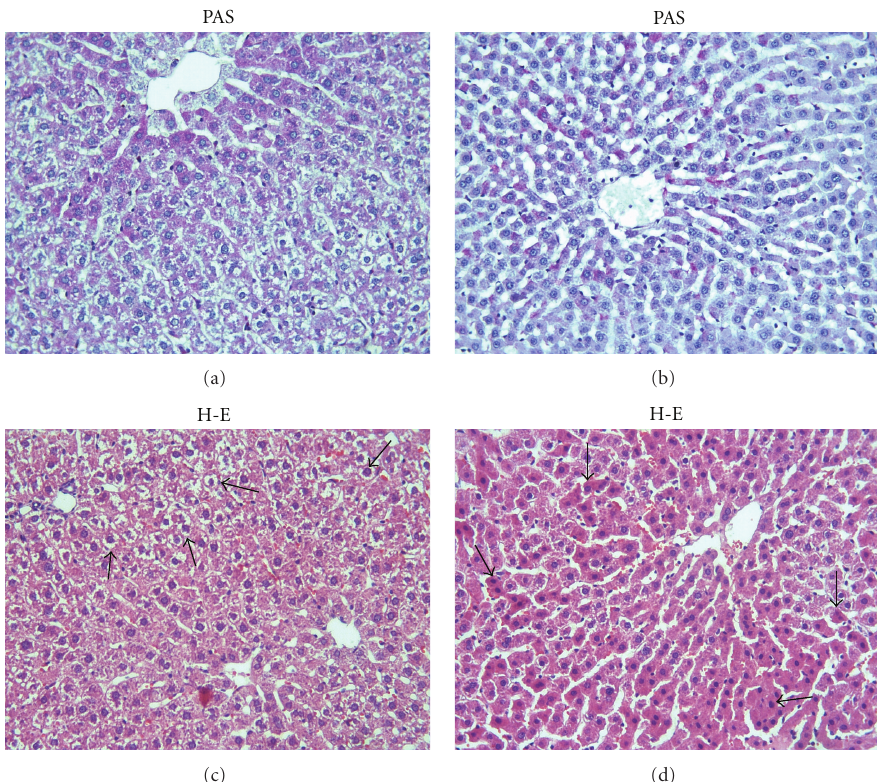
Figure 3: (a) Notice decreased glycogen storage in hepatocytes of Mtx + ML group. (b) View of glycogen storage in hepatocytes in ML + Mtx group. (c) The appearance of the swollen hepatocyte in Mtx + ML group (arrows). (d) Eosinophilic-stained hepatocytes are still observed (arrows) in ML + Mtx group. X66. Table 2: Comparison of the e ff ect of ML on microscopic damage caused by Mtx in liver. Parameters Control ML Mtx Mtx + ML